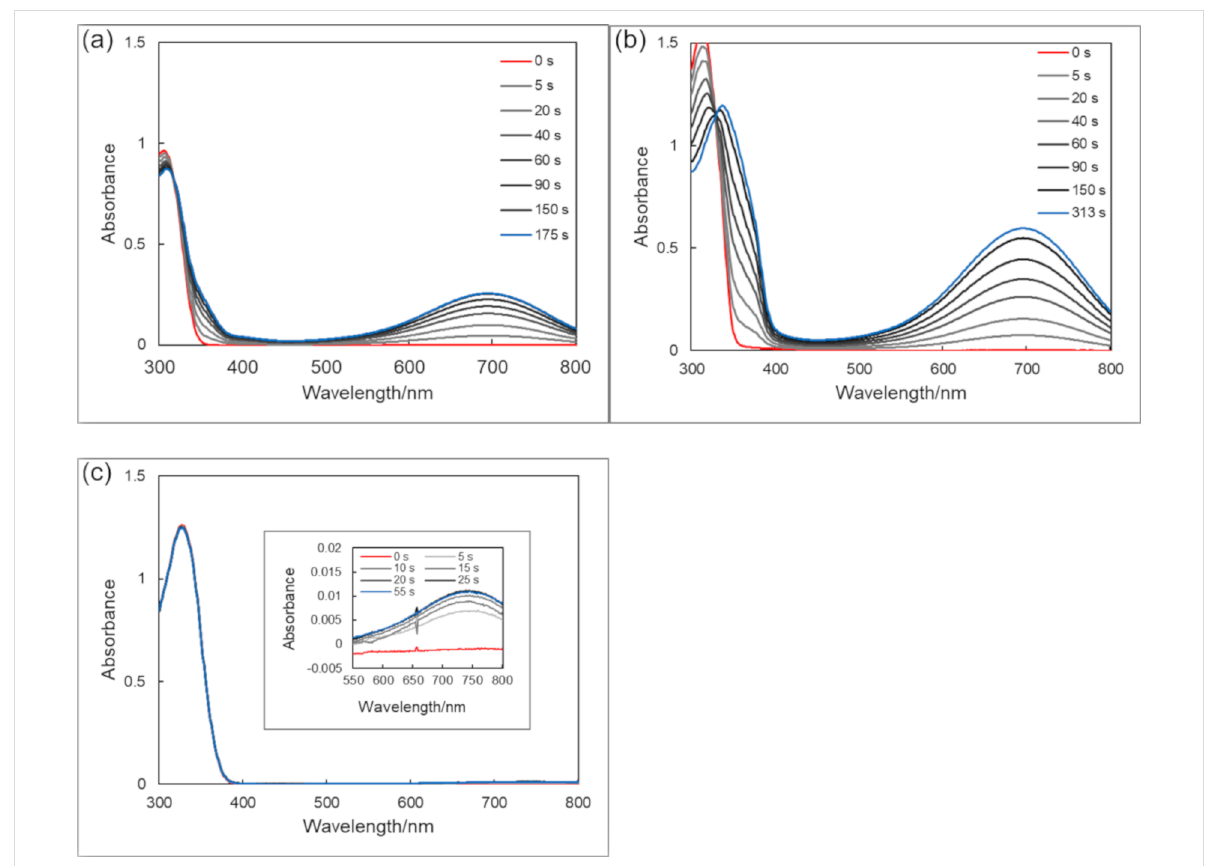
Figure 1: Absorption spectral change of triazoles 1o – 3o upon irradiation of 313 nm light in MeCN at 28 °C. Light intensity: 1.8 mW cm − 2 . (a) 1o . 4.44 × 10 − 5 mol dm − 3 . (b) 2o . 4.38 × 10 − 5 mol dm − 3 . (c) 3o . 4.73 × 10 − 5 mol dm − 3